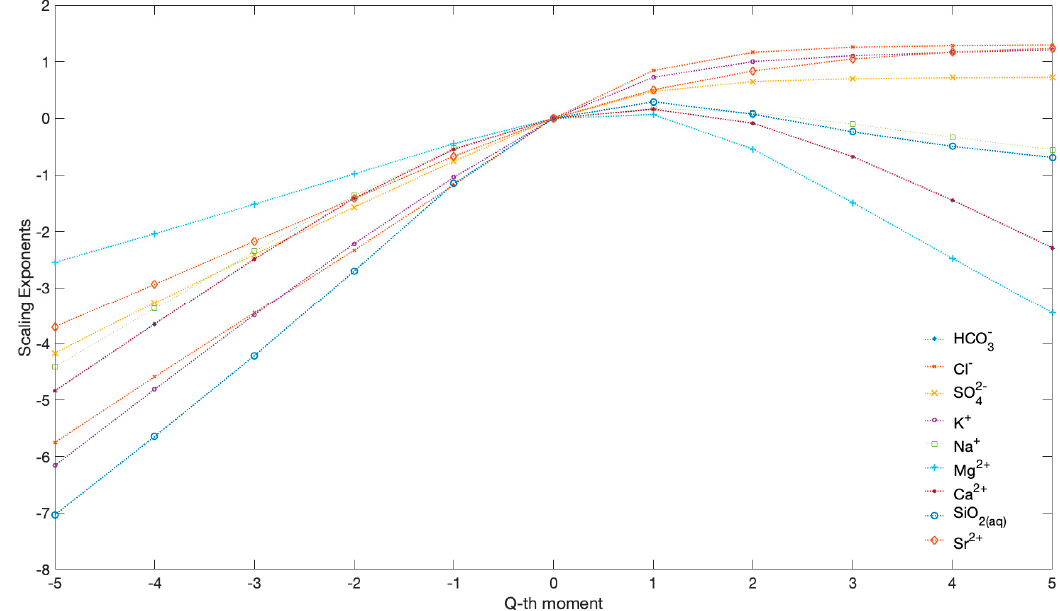
Figure 6. Relationship between the Q-th moment versus the scaling exponents for the clr-perturbation-subtraction values